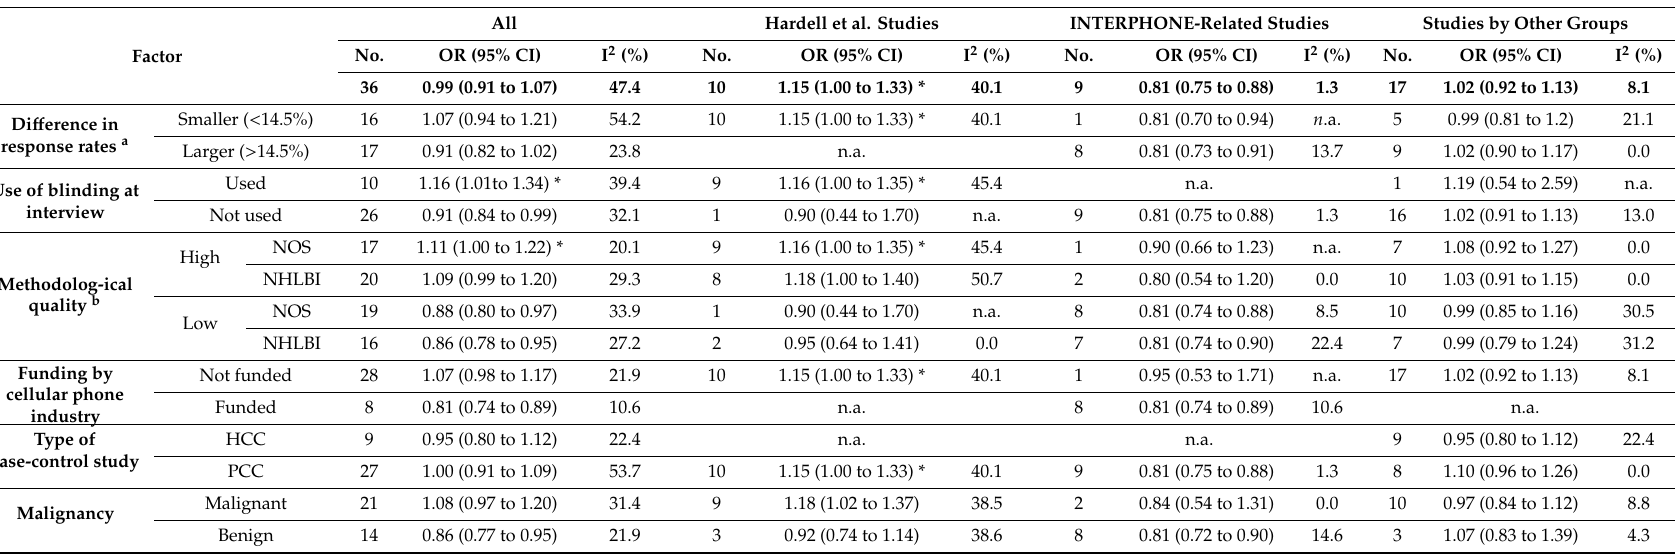
Table 2. Use of cellular phones and risk of tumors in subgroup meta-analysis of case-control